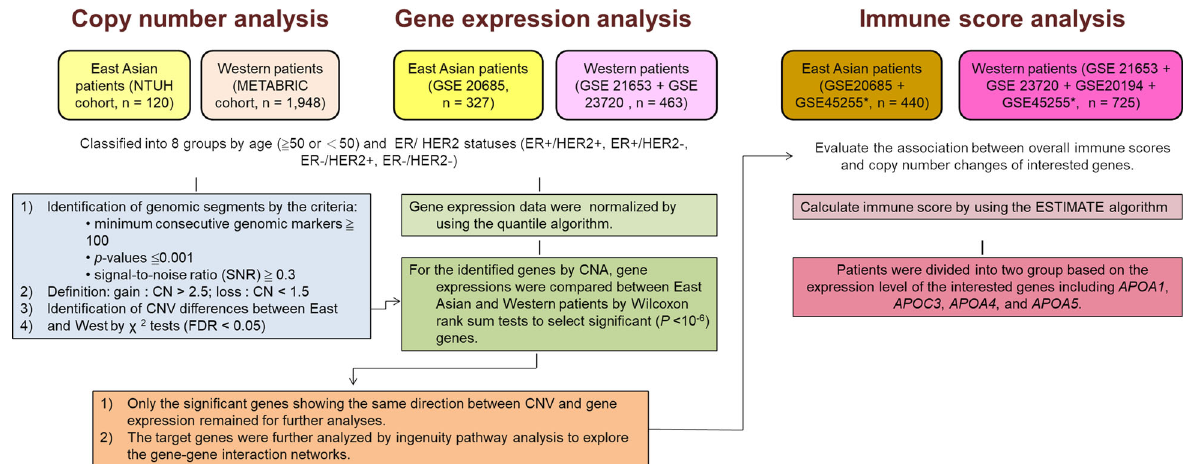
Fig. 1 Study fl ow diagram. The bioinformatics schema and statistical analyses for comparing the genetic differences between the breast tumors of East Asian and Western patients.